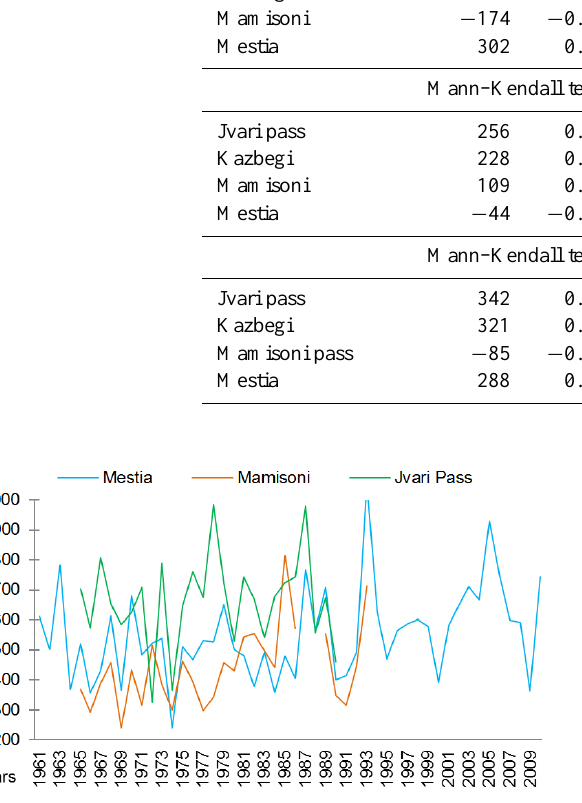
Figure 6. October–April precipitation for Mestia (1961–2010), Mamisoni (1965–1993) and Jvari Pass (1965–1990) meteorological